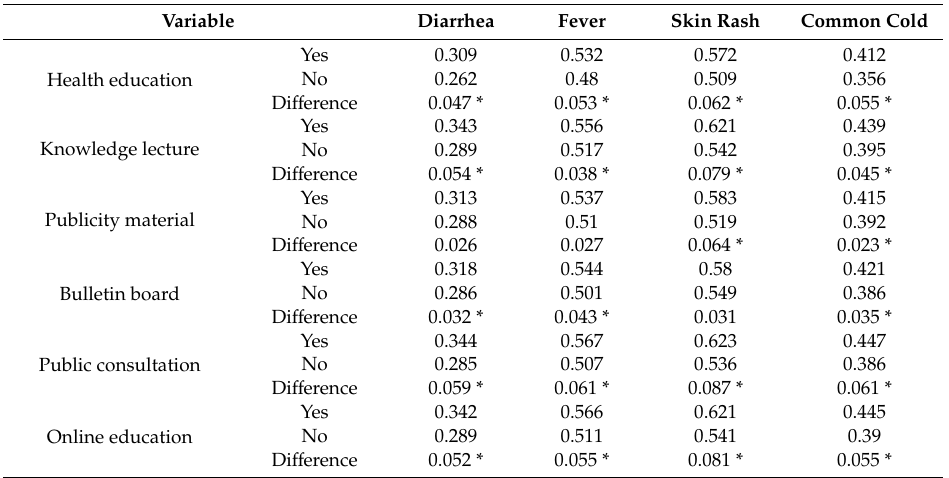
Table 3. Descriptive statistics and healthcare-seeking behavior